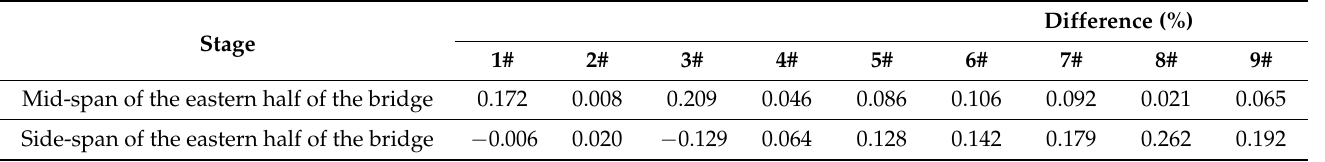
Table 1. The difference between designed value and measured value.